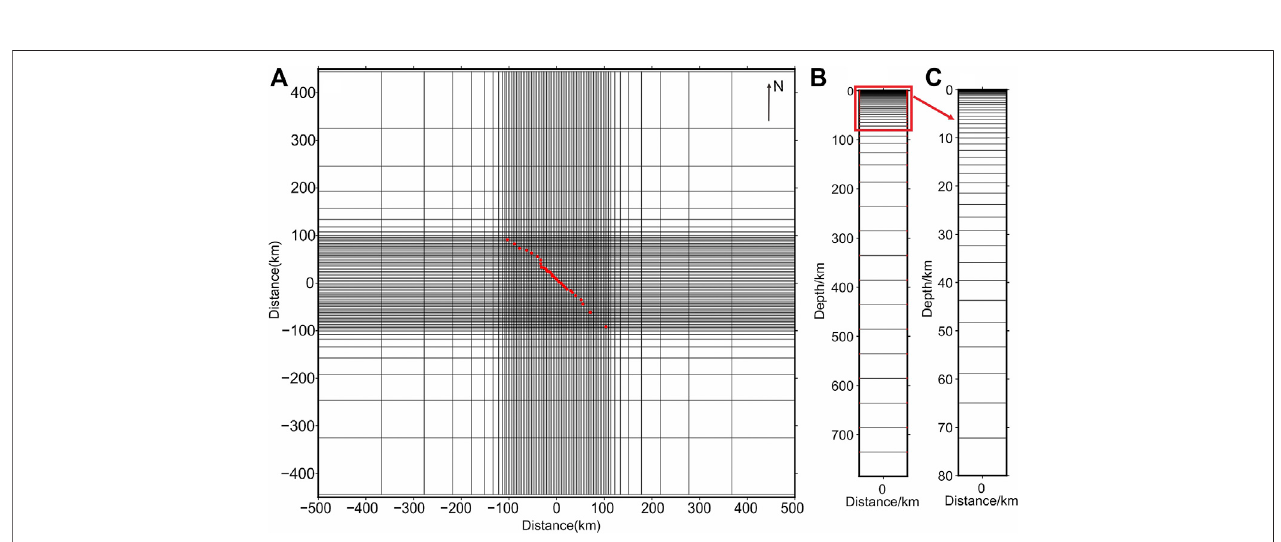
FIGURE 3| Initial model used for the three-dimensional inversion ofthe study region (A) horizontal grid, (B) verticalgrid, and (C) vertical grid of the target area. The red dots denote magnetotelluric (MT) sites.